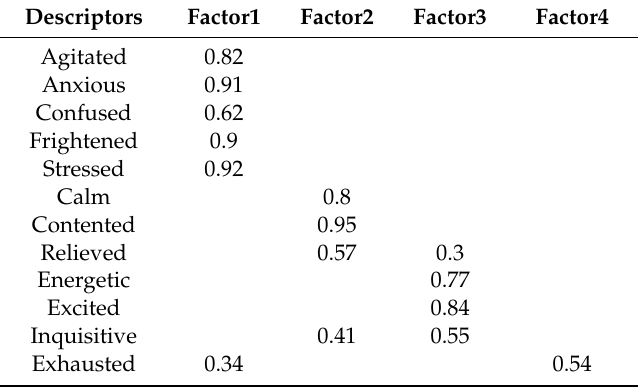
Table 2. Factor loadings of Factor Analysis of Fixed Term Descriptors applied by a panel of 16 students on 80 images of calves ( n = 20) during a calf roping event.